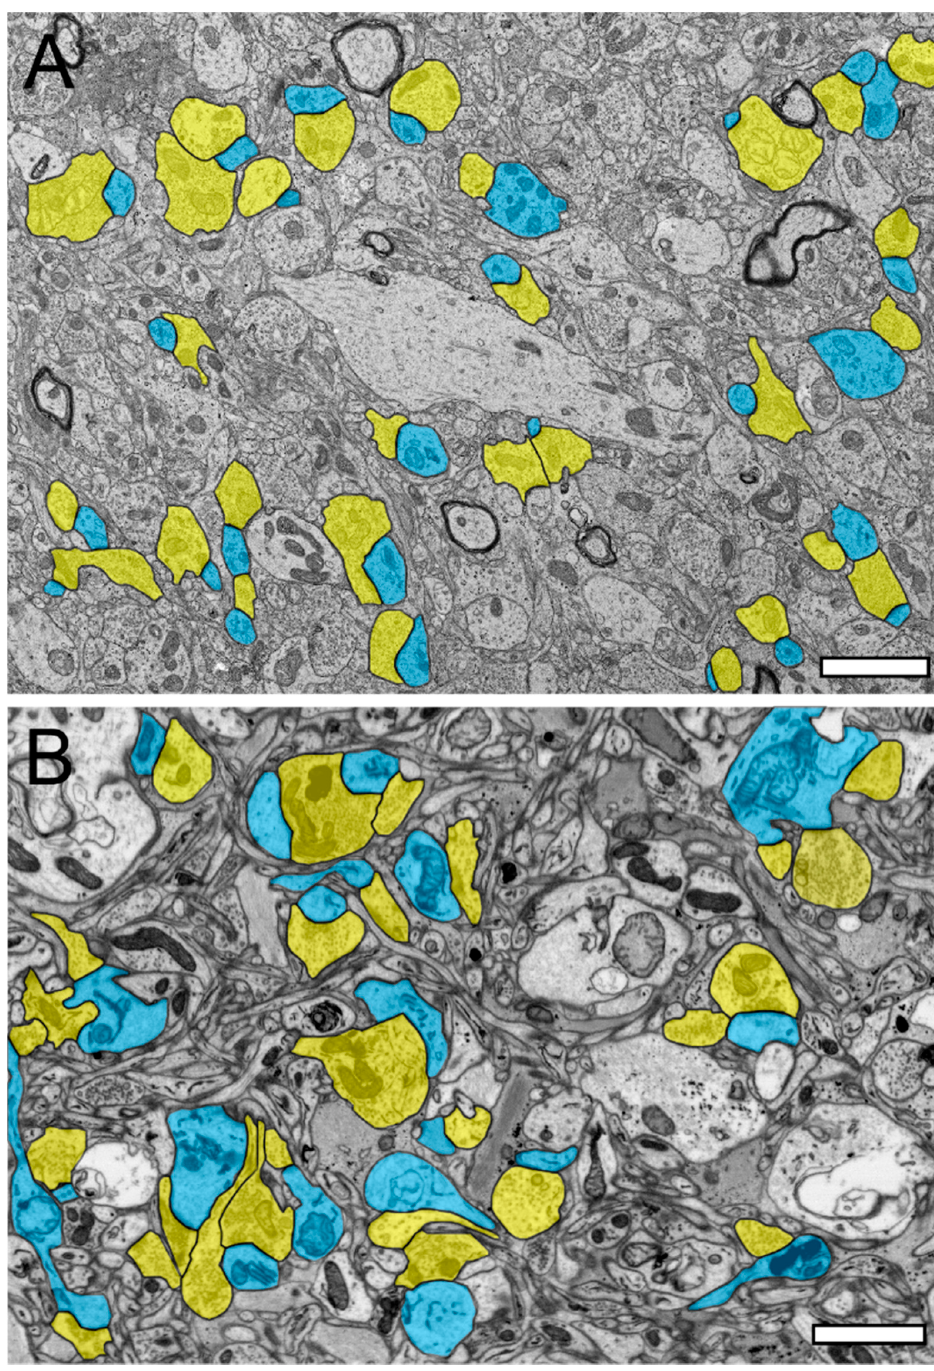
Figure 1. Synaptic organization of the neuropil in the human temporal lobe neocortex (TLN). ( A ), Low-power electron microscopy (EM) micrograph of the neuropil of L2 in the gyrus temporalis medialis of the TLN processed for TEM analysis. Here, several synaptic complexes, composed of a dendritic shaft or spine and a synaptic bouton, are highlighted in transparent yellow (synaptic boutons, or SBs) and transparent blue (dendritic shafts or spines). Note the high density of axo-spinous synaptic complexes. ( B ), Same layer, gyrus, and color code as shown in ( A ), but here, the tissue sample was processed for focused ion beam scanning EM (FIB-SEM) analysis. Note the different structural appearance of the neuropil between the TEM ( A ) and FIB-SEM ( B ) processed tissue samples. Scale bar in ( A , B ), 1 µm.